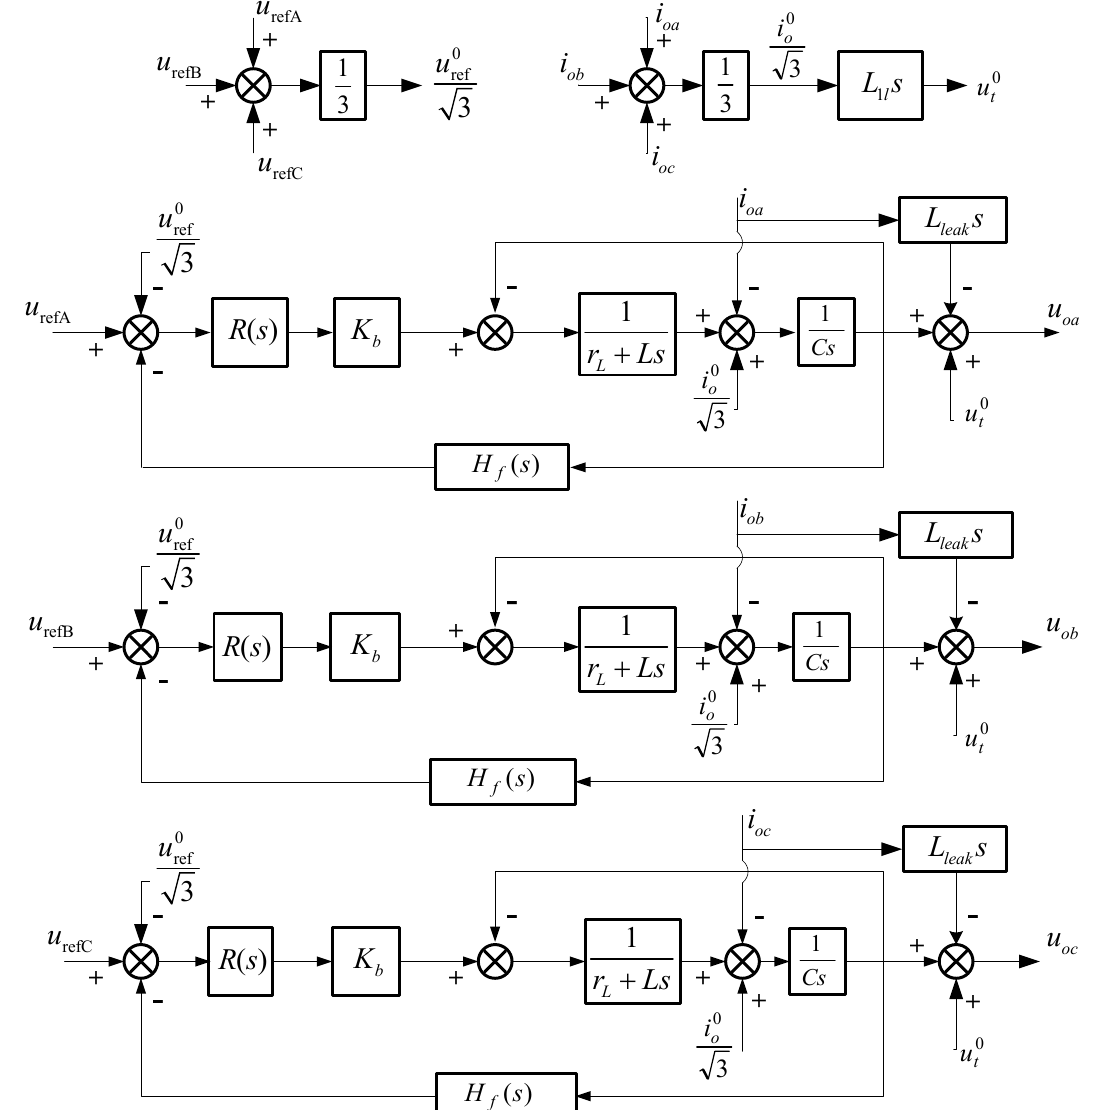
Figure 10. Block diagram for a three-phase inverter with PID control considering magnetic